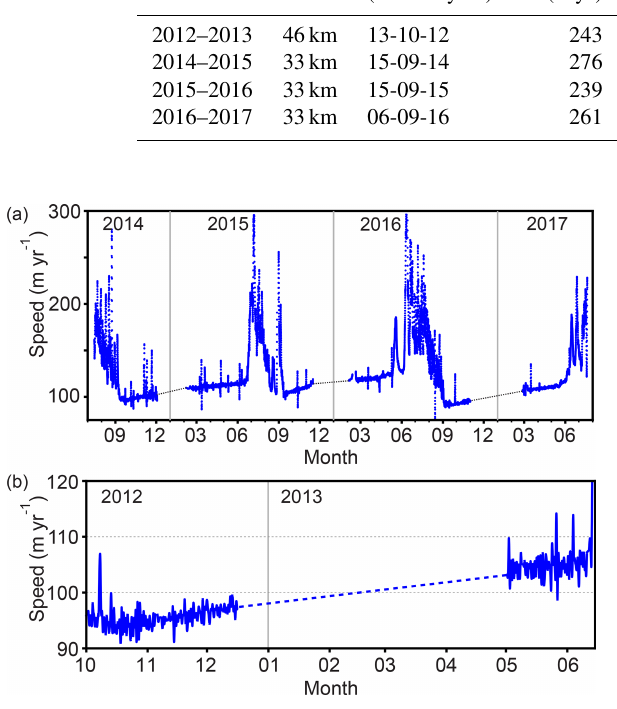
Figure 2. Ice flow speed measured with on-ice GPS stations and processed against the base station shown in Fig. 1: (a) 3 years of flow speed at the 33km site; (b) one winter of flow speed at the 46km site. Dashed lines indicate missing data due to GPS shutdown due to midwinter power loss. All measurements indicate higher speeds in late winter than early